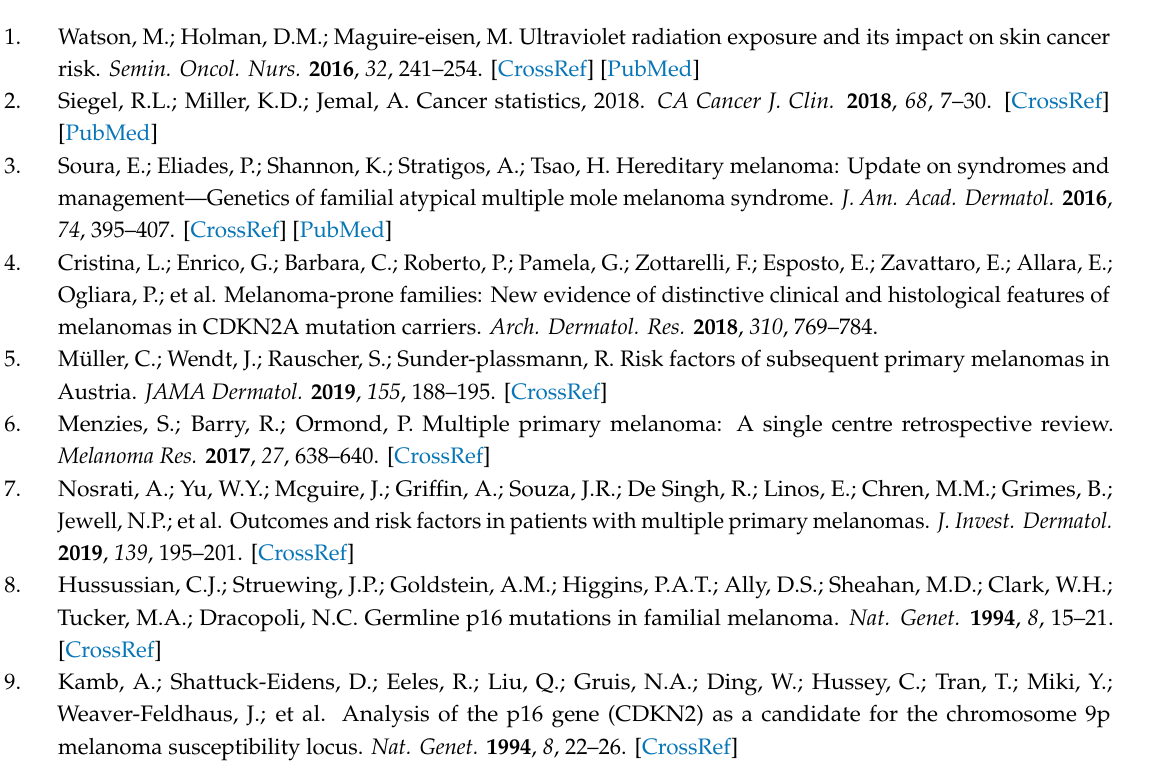
(Solo) p.Arg834Cys pathogenic variant, Figure S3: Analysis of the frequency of mutation in additional datasets, Table S1: Selected variants after bioinformatics analysis and subsequent Sanger validation, Table S2: Variant impact prediction by in silico tools, Table S3: Structural models of CDH23 and ARHGEF40 obtained by homology modelling using the SWISS-MODEL server, Table S4: Primer list employed for variant validation, Table S5: Patient clinicopathological